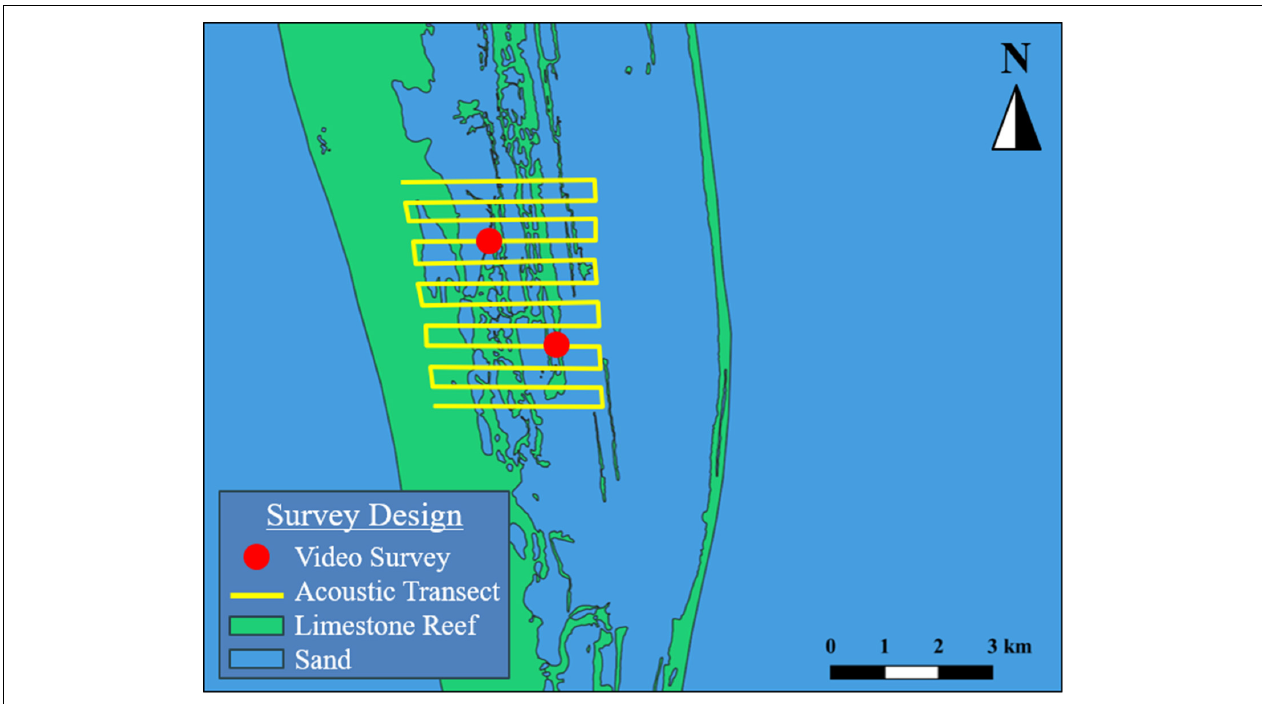
FIGURE 4 | Example echosounder surveys (parallel line) paired with stationary video deployments (dots) along reef sand interface near promontories used to validate user